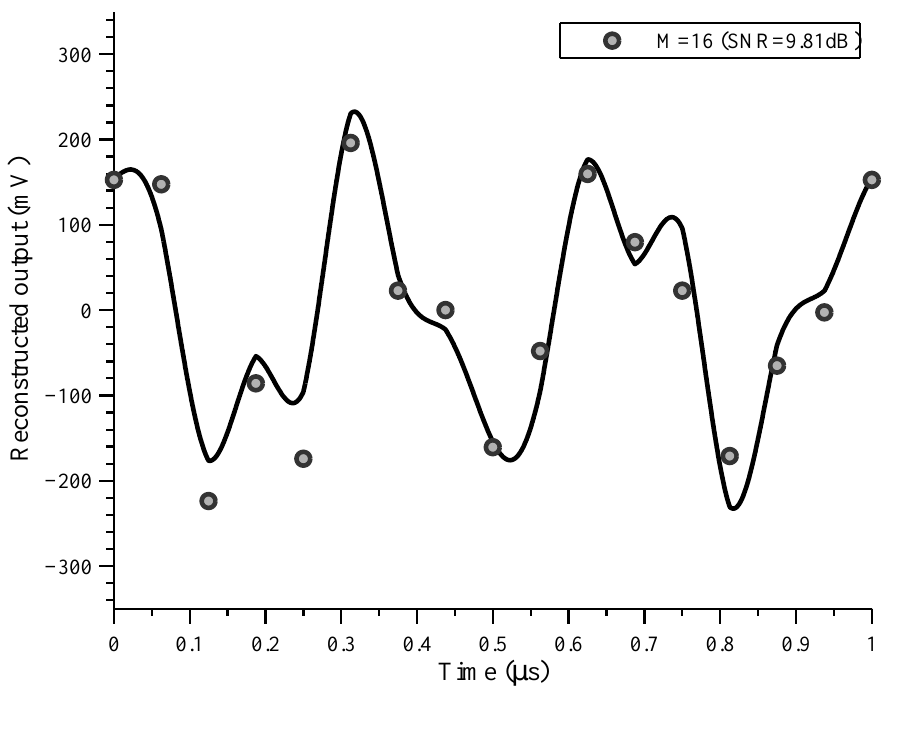
Figure 13. Reconstruction of input signal composed of two randomly chosen basis elements with random